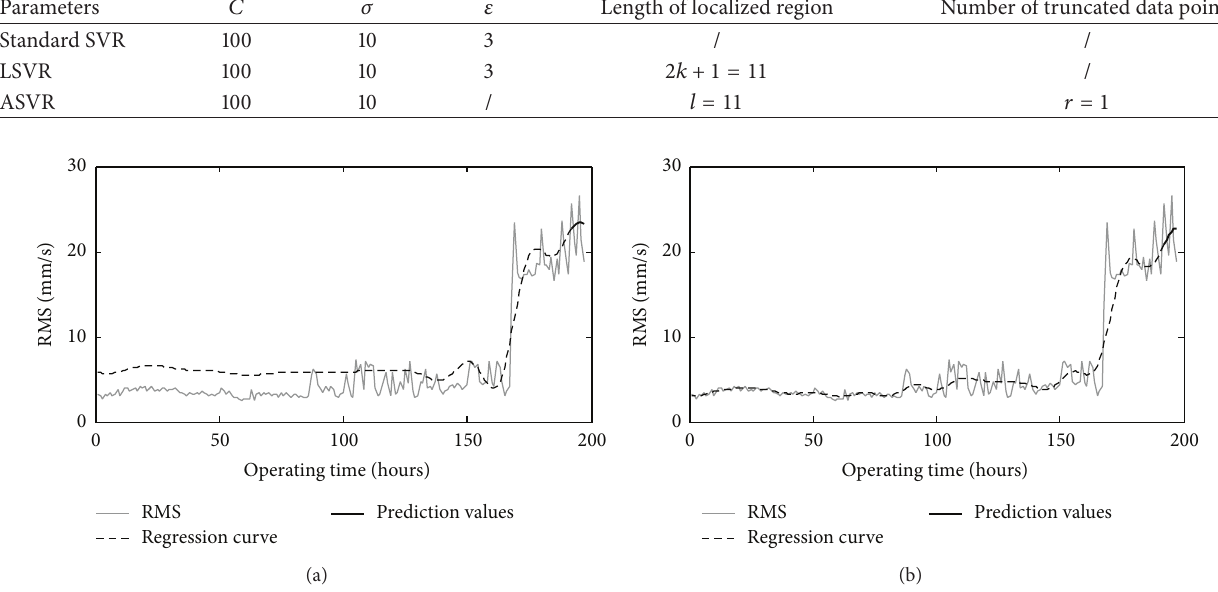
Figure 4: Prediction for the state of descaling pump number 1: (a) prediction results of standard SVR; (b) prediction results of ASVR.